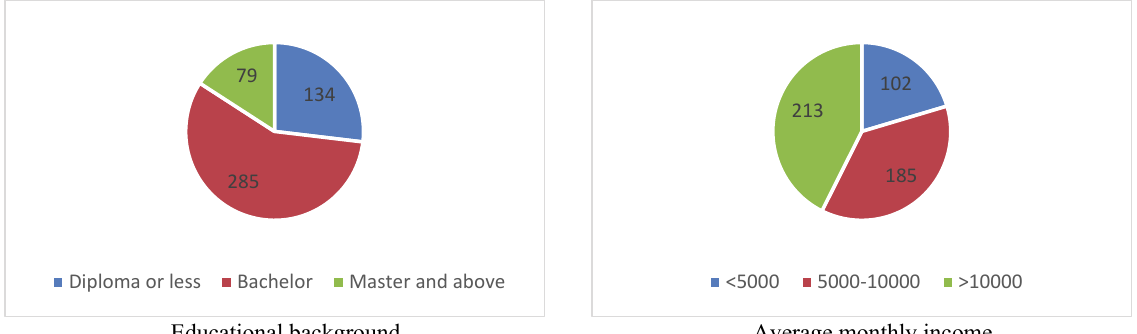
Fig. 2. Personal characteristics of the